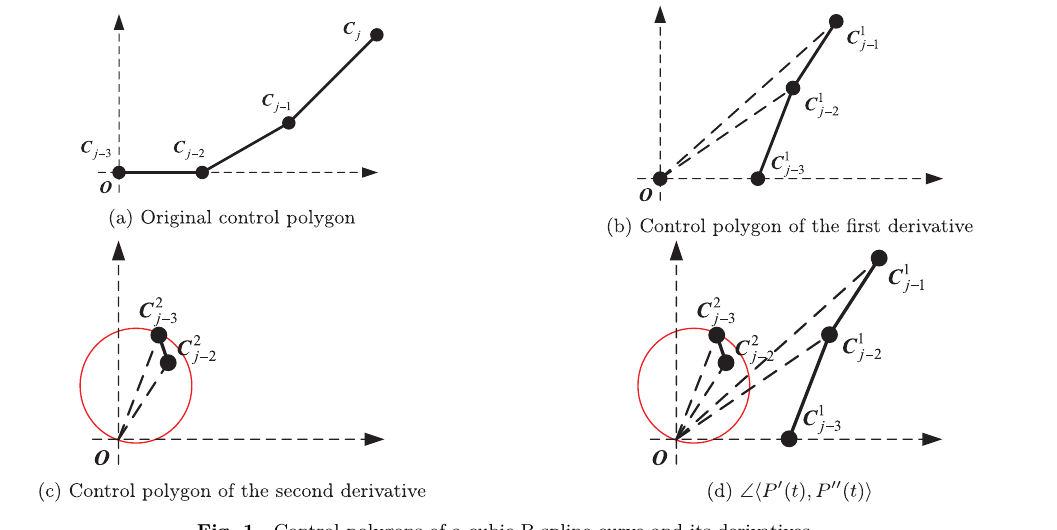
Fig. 1 Control polygons of a cubic B-spline curve and its derivatives.